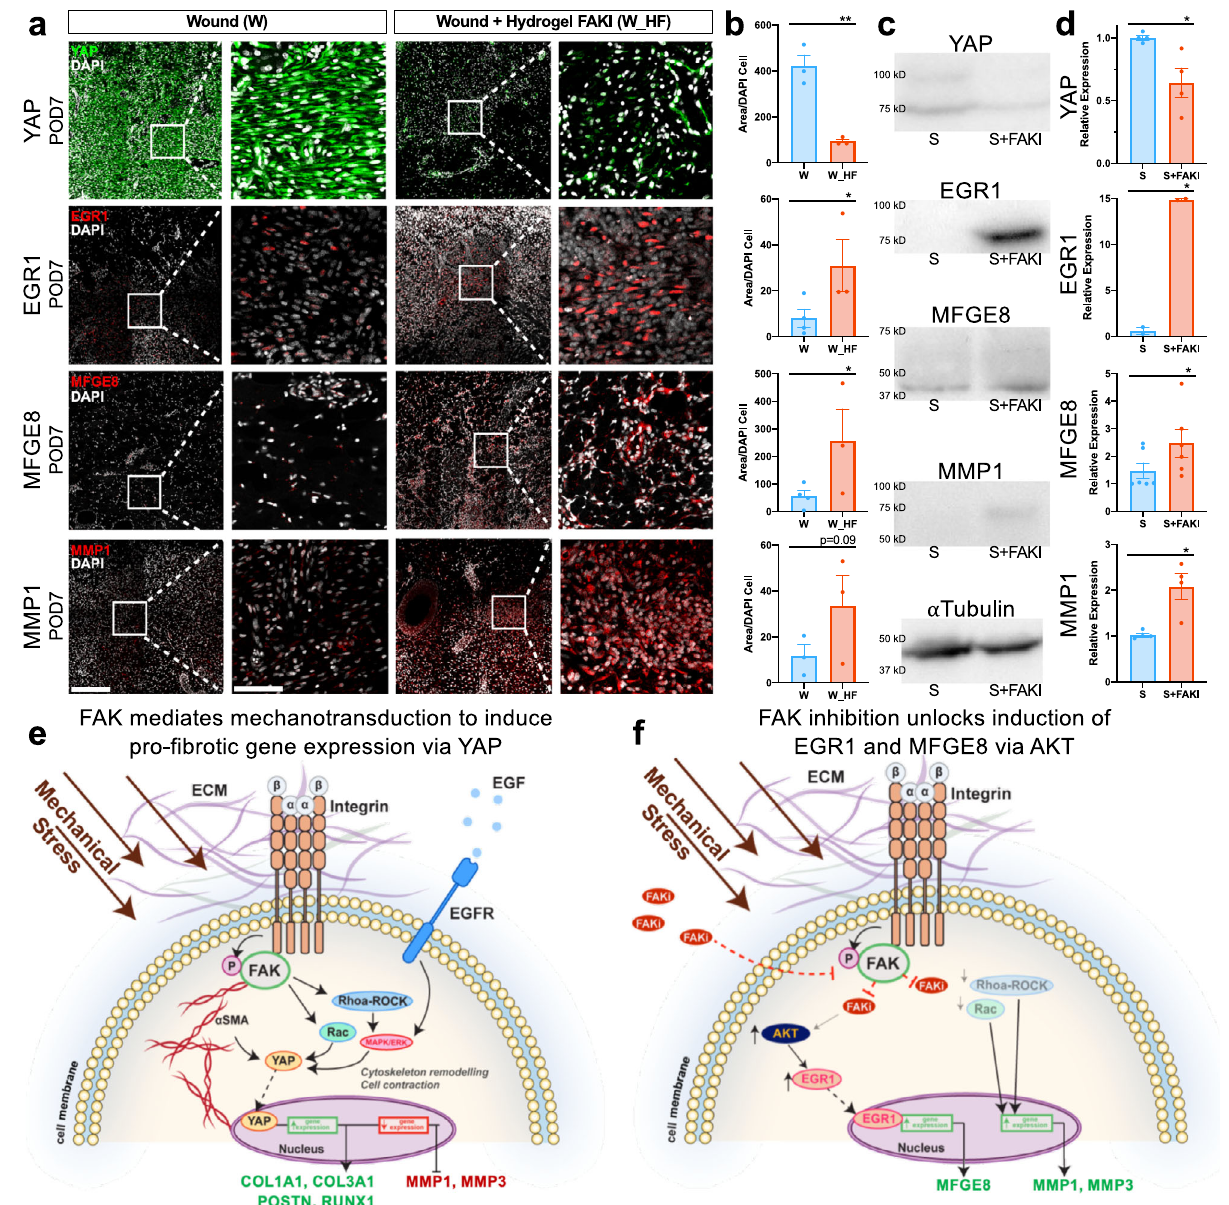
Fig. 6 Protein level con fi rmation of human scRNA-seq observations in large animal comparator. a, b Protein level con fi rmation performed using immuno fl uorescence staining of wounded and untreated (W, left, blue, n = 3 independent wounds) vs. wounded and FAK-inhibited (W_HF, right, red, n = 3 independent wounds) porcine dermal tissue sections at POD7 (from Figs. 1, 2). Staining for YAP (encoded by the gene YAP1; ** p = 0.0015), which contributes to myo fi broblast differentiation, mechanotransduction, and scar formation, or EGR1 (* p = 0.0415), MFGE8 (* p = 0.0499), and MMP1, which contribute to regenerative healing and collagen degradation. Scale bar: 200 µ m . Magni fi ed image scale bar: 50 µ m. c, d Western blot protein quanti fi cation of human fi broblasts from repeated experiments utilizing our collagen scaffold system of YAP1 ( n = 4 independent collagen scaffolds per condition, * p = 0.0493), EGR1 ( n = 2 independent collagen scaffolds per condition, * p = 0.0134), MFGE8 ( n = 6 independent collagen scaffolds per condition, * p = 0.0164), and MMP1 ( n = 4 independent collagen scaffolds per condition, * p = 0.0471). e, f Schematic of the proposed cellular mechanism of action showing how increased mechanical stress drives fi brosis and scar formation, while FAK inhibition unlocks AKT activation of EGR1 and MFGE8. Statistical comparisons were made using either unpaired ( b ) or paired ( d ) two-tailed t -tests. Each datapoint represents an independent wound or collagen scaffold. All data represent mean ± SEM. Representative images are shown from similar images across all